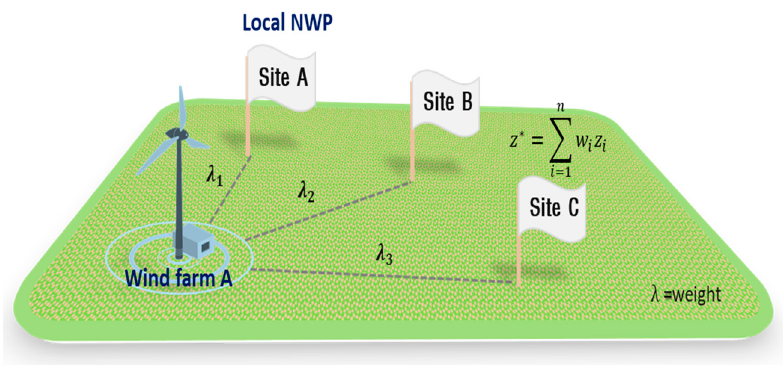
Figure 2. The concept of the Kriging technique.